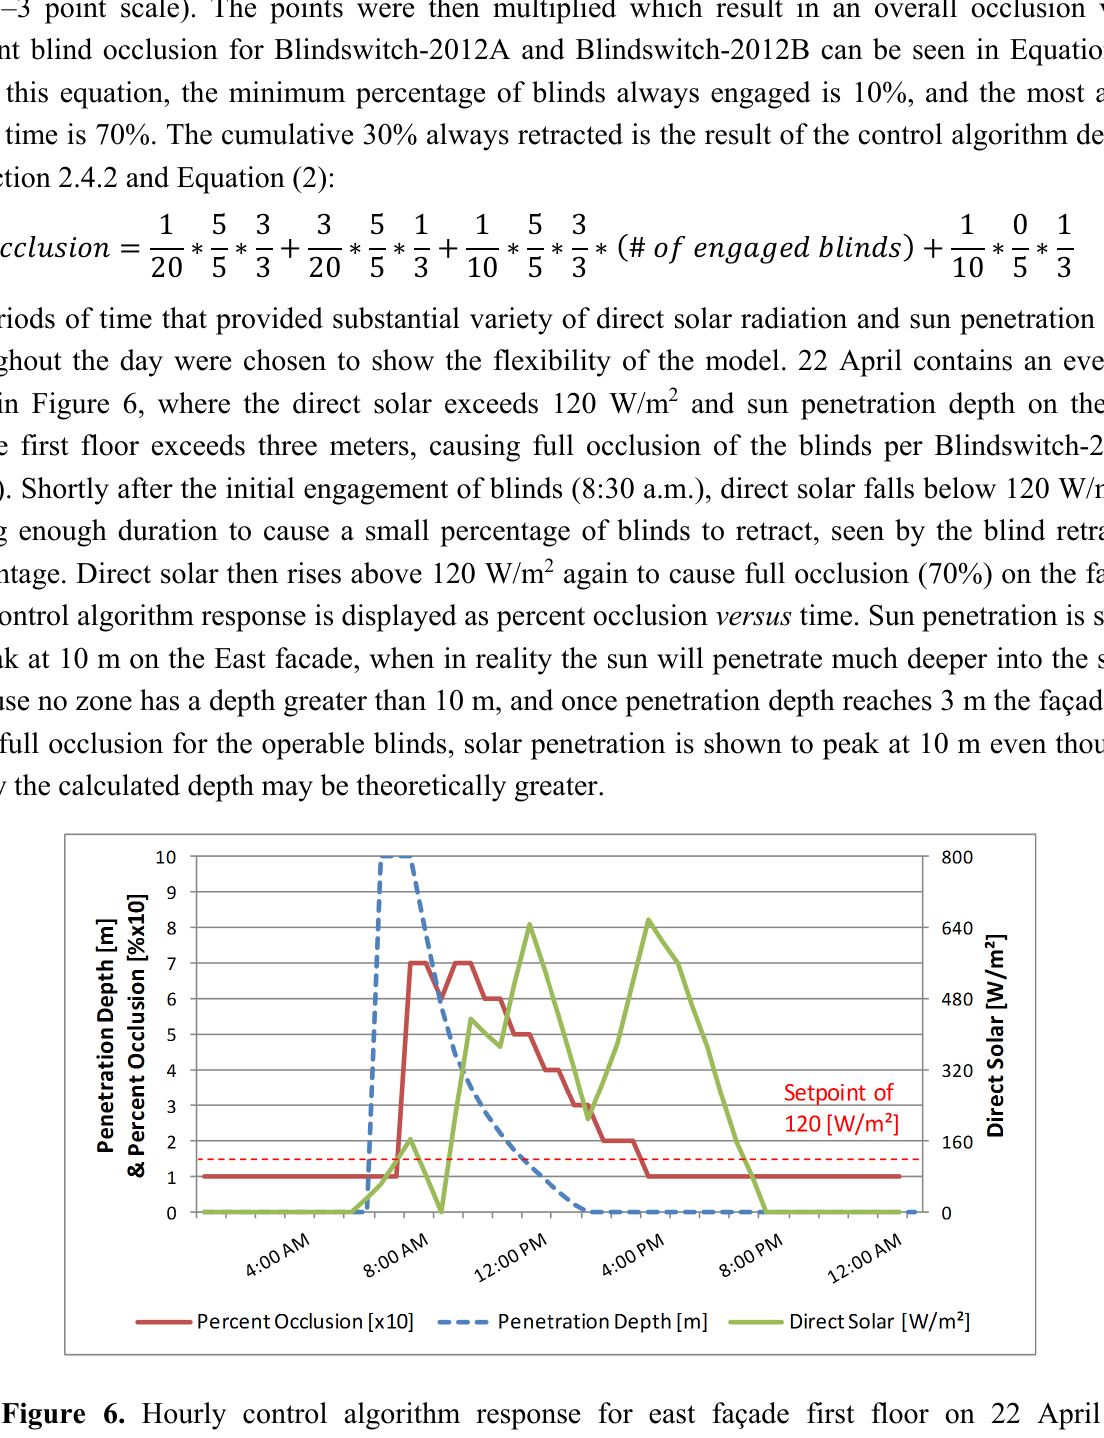
Figure 6. Hourly control algorithm response for east façade first floor on 22 April (Blindswitch